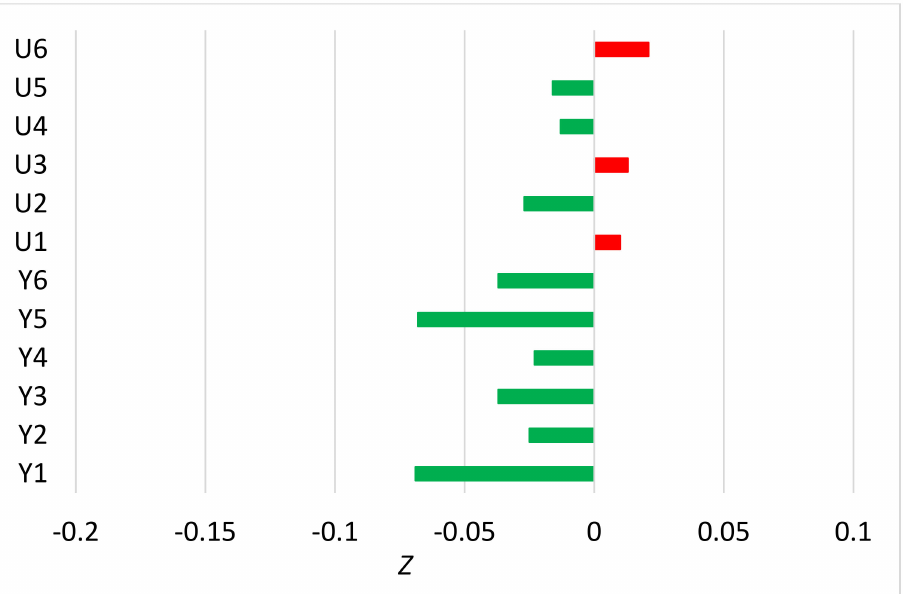
Figure 5. The same as Figure 1, but for the network mean annual